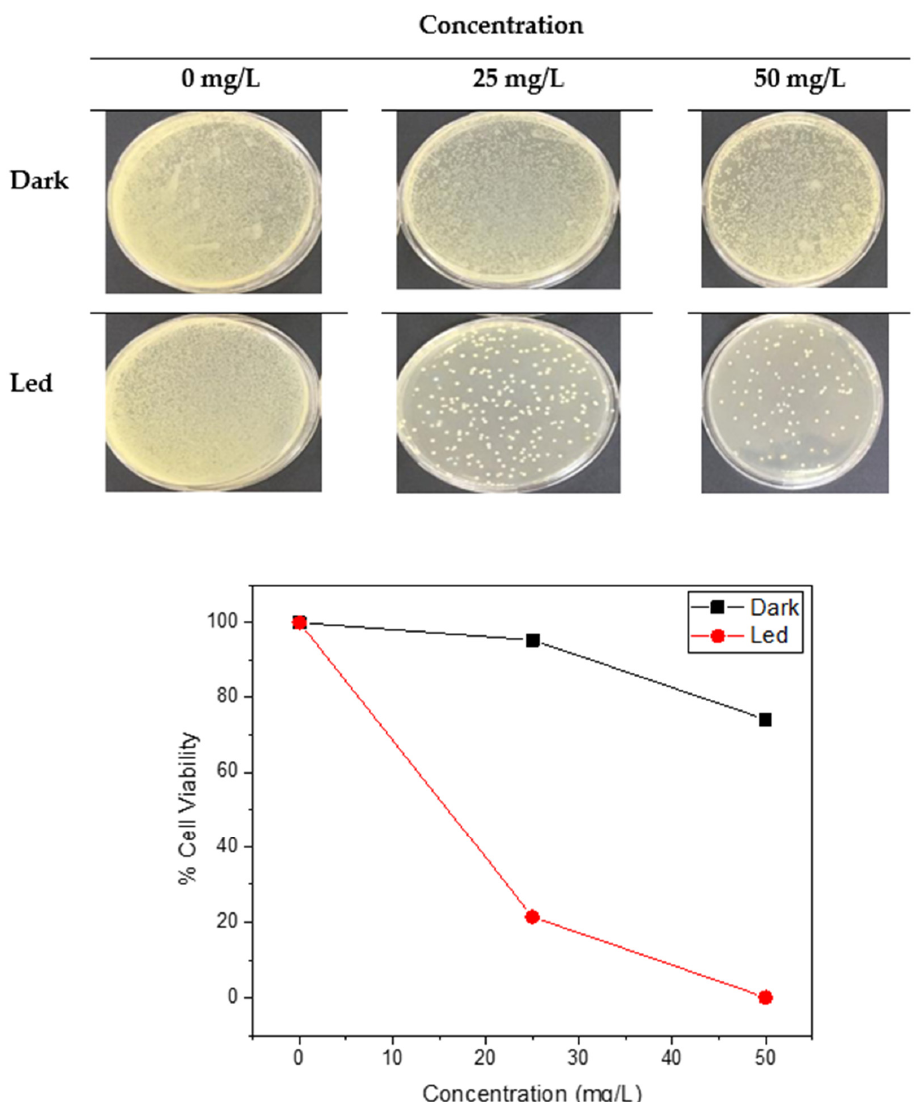
Figure 6. Antimicrobial photodynamic therapy of γ‐ Fe 2 O 3 ‐ CA ‐ Leu ‐ Gly ‐ PDX.